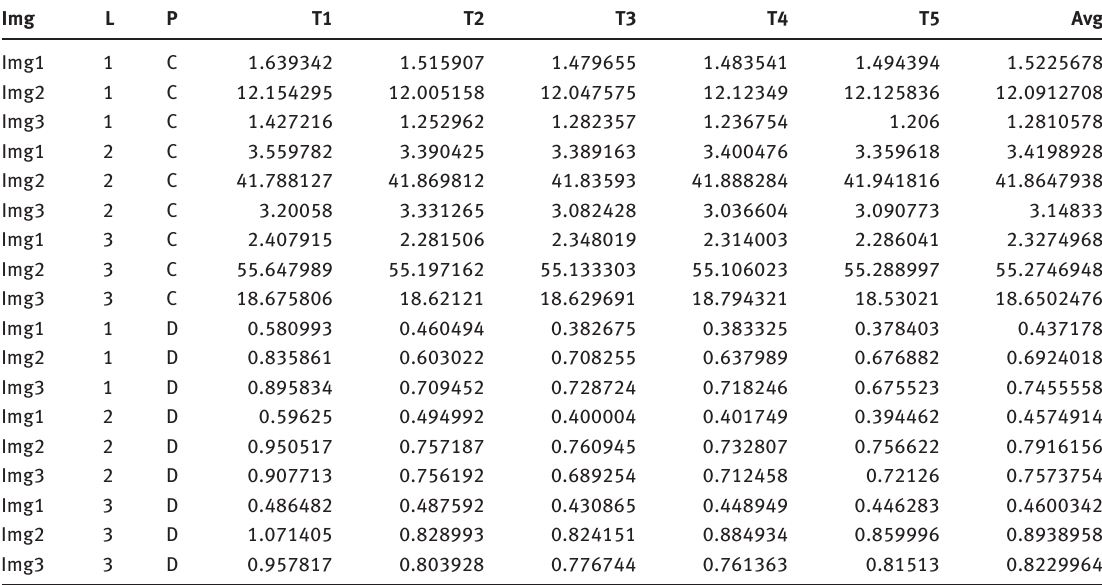
Table 3: Compression and Decompression Times in Parallel Wavelet Transform Algorithm.